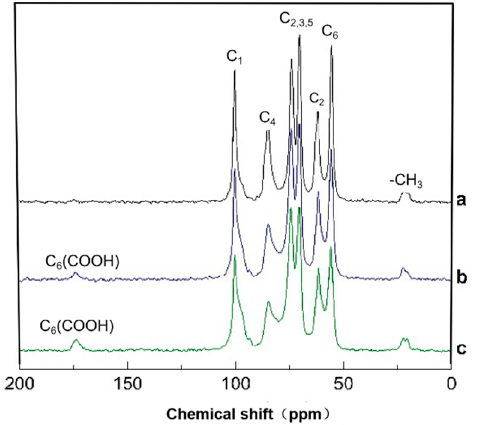
Figure 6. Solid-state CP / MAS 13 C-NMR spectra of original and oxidized chitosan: ( a ) original chitosan; ( b ) oxidized chitosan with 29.4% of DO; ( c ) oxidized chitosan with 55.5% of DO.